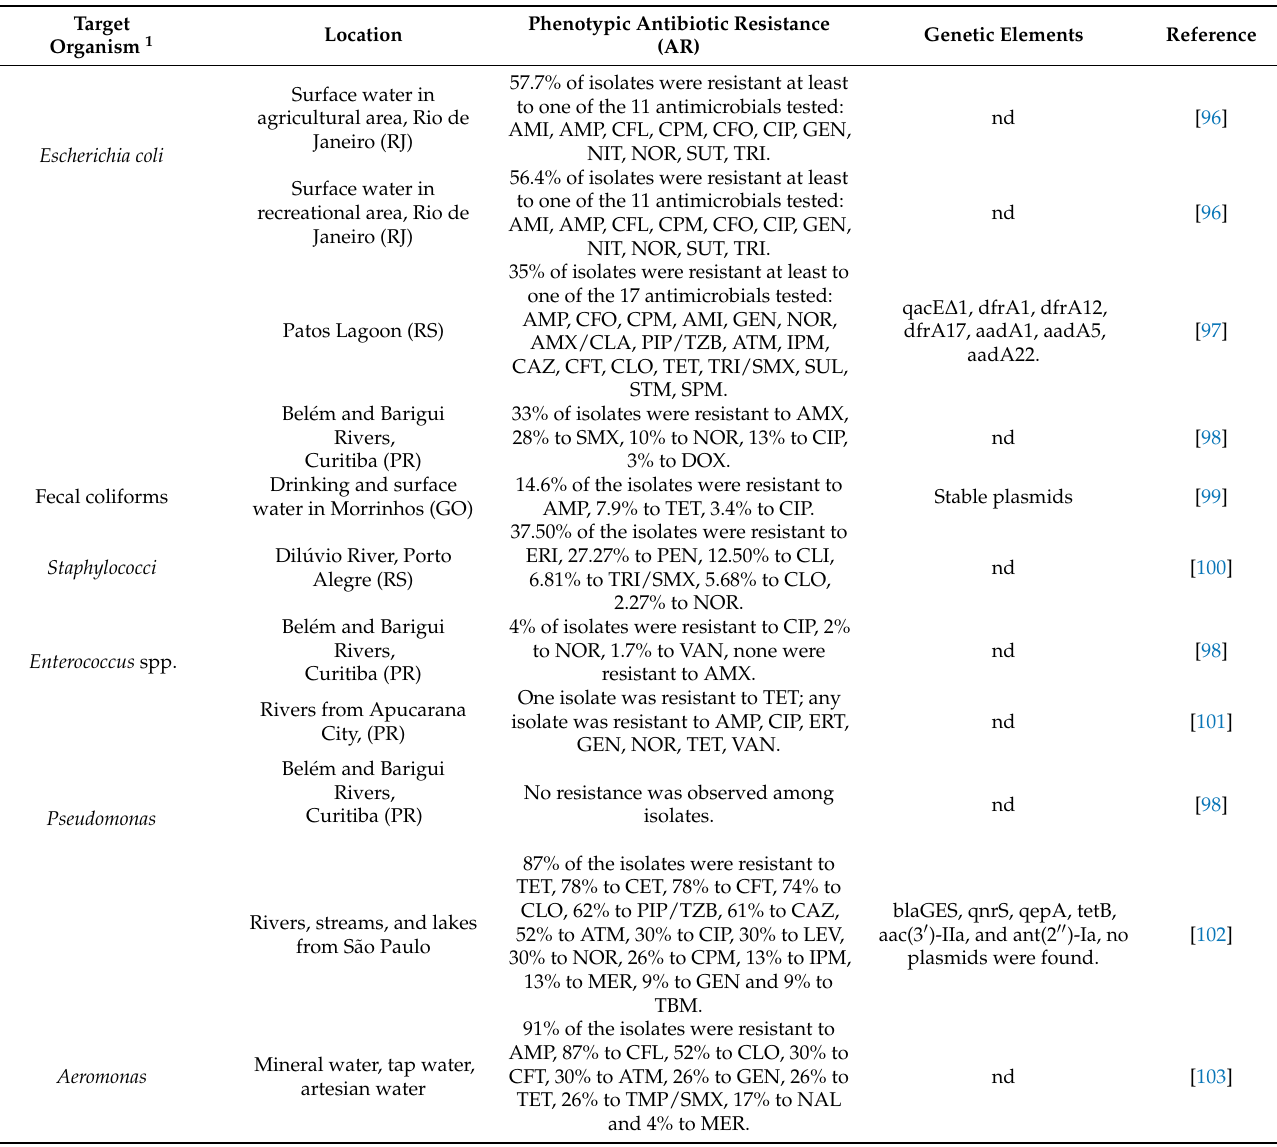
Table 4. Reported occurrence of resistant bacteria (ARB) and resistance genes (ARG) in Brazilian surface waters (to be